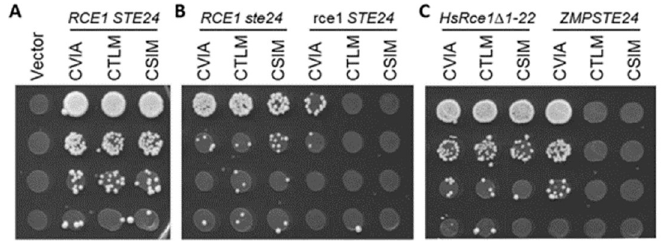
Fig 6. Rce1 is responsible for cleavage of yeast a-factor-CSIM. Yeast strains expressing the indicated a -factor Cxxx variant as the sole source of a -factor were evaluated as described for Fig 3 in the context of yeast and human CaaX proteases. Yeast strains expressing A) both yeast CaaX proteases (SM2331, mfa1 Δ mfa2 Δ ), B) one or the other yeast CaaX protease (yWS2393, mfa1 Δ mfa2 Δ ste24 ; yWS2462, mfa1 Δ mfa2 Δ rce1 ), or C) plasmid-based human CaaX proteases (pWS130, HsRce1 Δ 1–22 ; pWS1609, ZMPSTE24 ) in a strain lacking both yeast CaaX proteases (yWS164, mfa1 Δ mfa2 Δ rce1 ste24